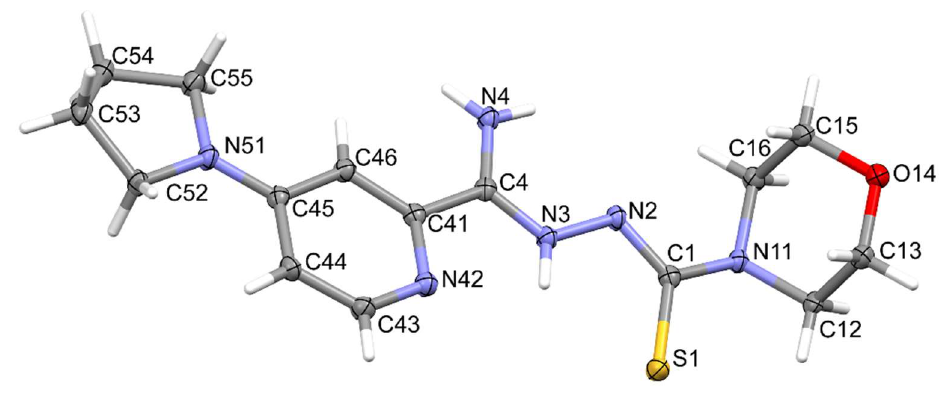
Figure 3. The molecular structures of compounds 1 – 6 , showing the atom-labeling schemes. Displacement ellipsoids are drawn at the 50% probability level, and H atoms are shown as small spheres of arbitrary radii. Drawing prepared with Mercury software.